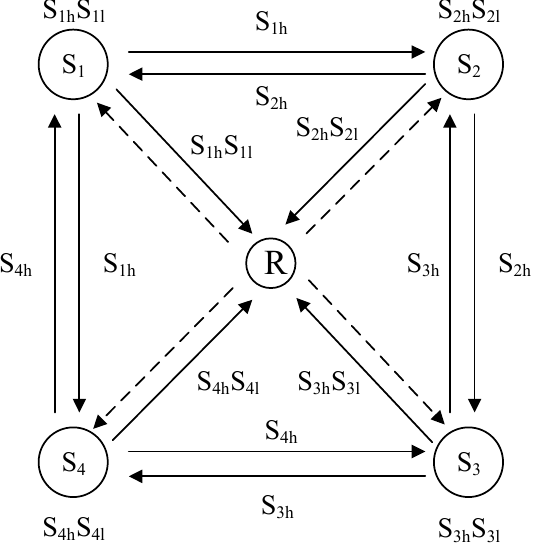
Figure 1. Relay network model with asymmetric channel conditions.